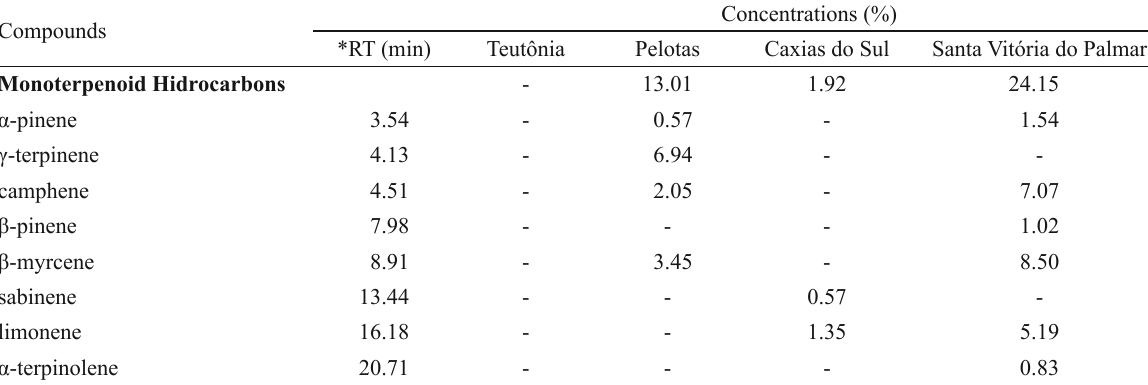
Major chemical compounds of four chemotypes of Lippia alba essential oils.